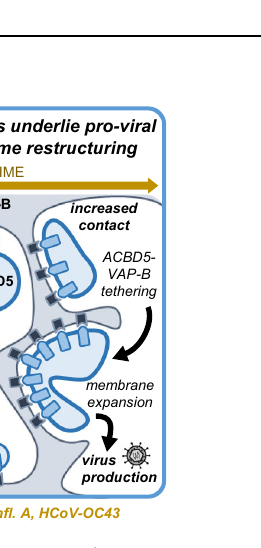
Fig. 5 | ACBD5-mediated ER-peroxisome contacts underlie HCMV-driven changestoperoxisomesizeandnumbers.A Averagepeptideabundances(scaled to mean) of ACBD5 (circle) and its ER tether VAP-B (hexagon) during HCMV infection, compared to ACBD4 and VAP-A (light blue lines). Shaded regions are SEM, and p values are by one-way ANOVA to Mock (data is from MCS-PRM quan- ti fi cationasinFig.1, N =6biologicalreplicateswith ≥ 3peptides/proteinmonitored in each replicate, see Supplementary Data 1 for complete list of peptides). B PLA quanti fi cation of endogenous ACBD5-VAP-B interactions. Plotted are PLA signal counts (solid line at mean, dotted lines at quartiles, N ≥ 40 cells/timepoint, ** p ≤ 0.01,*** p ≤ 0.001bytwo-tailedstudent ’ st-testtoMock). C MoviesofER(cyan) and peroxisomes (white/red) before and 120 hpi, showing whole-cell and zoomed stills(whitecircles,lower).Scalebars10 µ m. D Fixed fi broblastsinlate(72 – 120hpi) stages of HCMV infection, labelled for: ER (cyan), peroxisome membranes (red), and HCMV IE1 (magenta). Each channel from a zoomed region (white circles) is shown at right, including an ER-peroxisome overlap mask heat-colored by increasingoverlap.Arrowsindicateenlarged(yellow)orsmall(white)peroxisomes, localizing with expandedortubularER, respectively. Scalebars10 µ m. E IF analysis of peroxisomes(PEX14antibody)beforeand120hpi, comparing controlto ACBD5